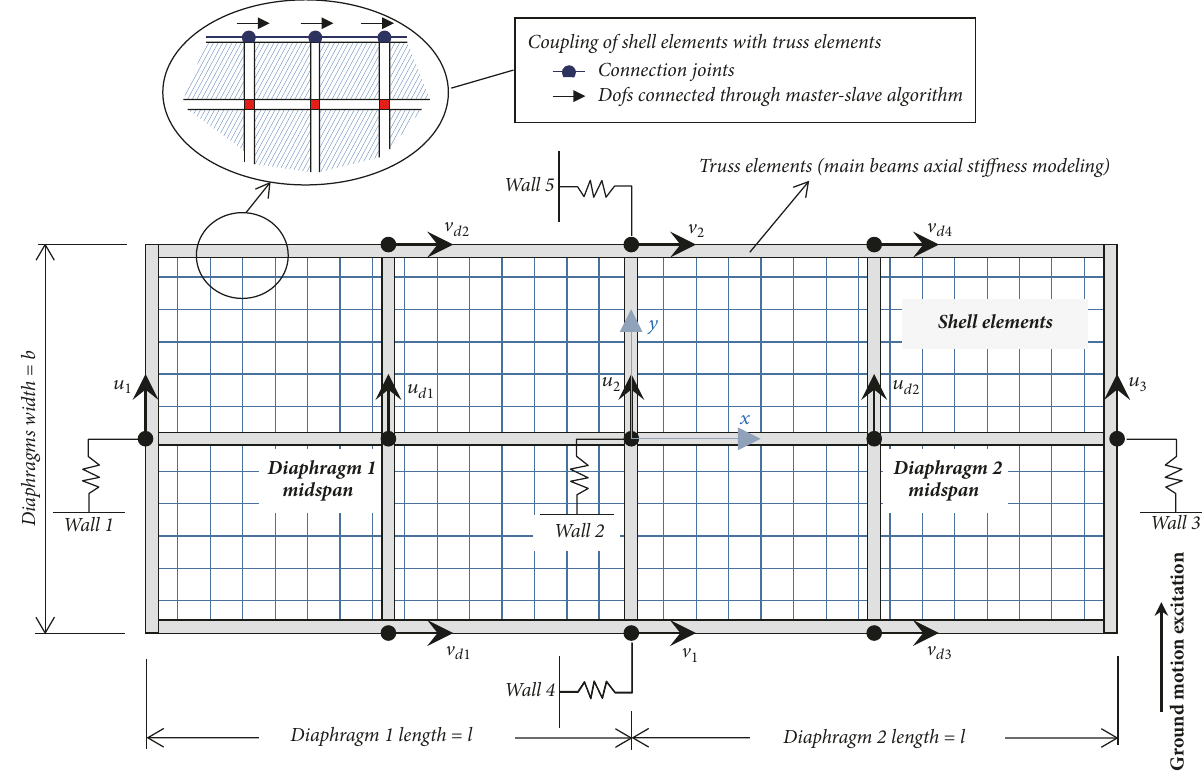
Figure 4: Finite element model of structures and main displacement